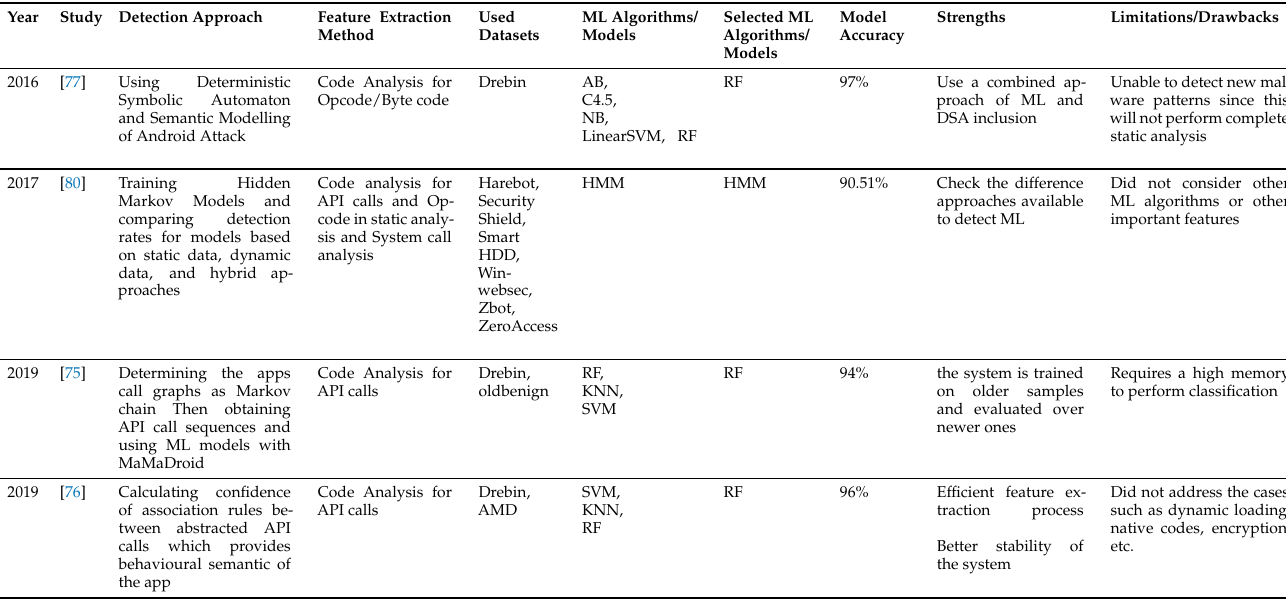
Table 3. Code based static Analysis with ML (Model Accuracy is above